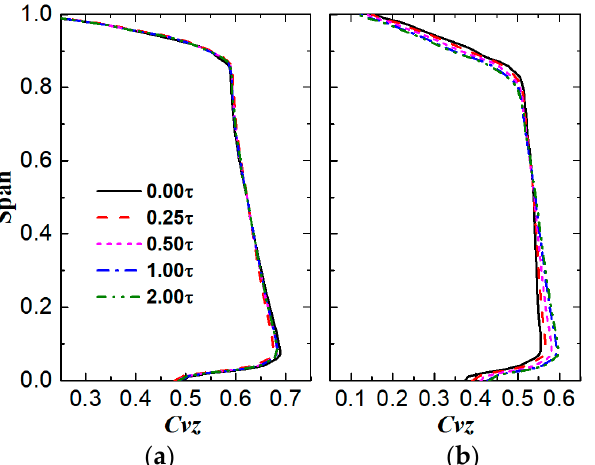
Figure 19. Circumferentially averaged normalized axial velocity at stator inlet. ( a ) In the DE condition; ( b ) in the NS condition.